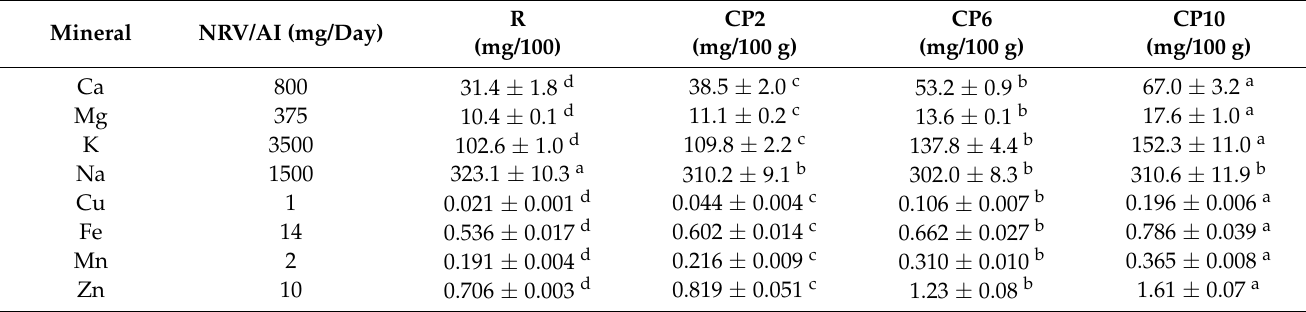
Table 3. Mineral composition (expressed as mg per 100 g of